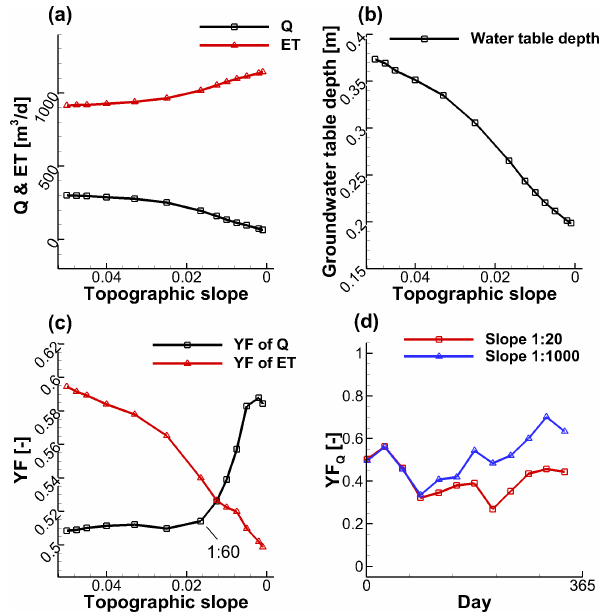
Figure 6. The simulated (a) Q and ET, (b) spatially-averaged depth of the groundwater table from the land surface, and (c) young water fraction in streamflow YF Q and evapotranspiration YF ET , in rela- tion to the topographic slope for the simulated catchments. (d) Tem- poral variations of YF Q for a steep landscape (slope 1 : 20) and a flat landscape (slope 1 :